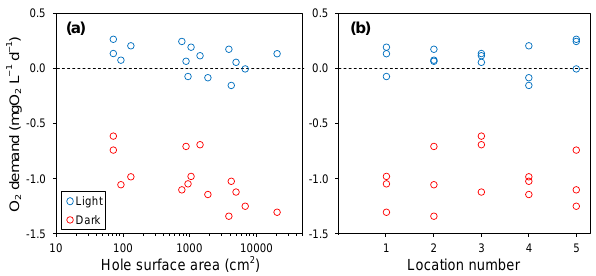
Figure 13. Variation in biological oxygen demand with (a) cry- oconite hole surface area and (b) sampling location, 6–7 Au- gust 2012. To convert the measured O 2 demand to inferred C stor- age in mgCm − 2 d − 1 , multiply the vertical axis values by 29.1.